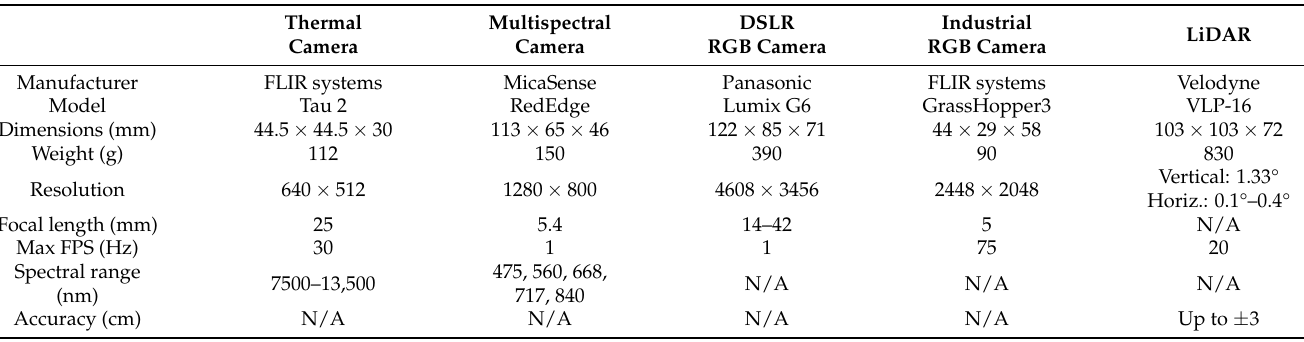
Table 1. Specification of the